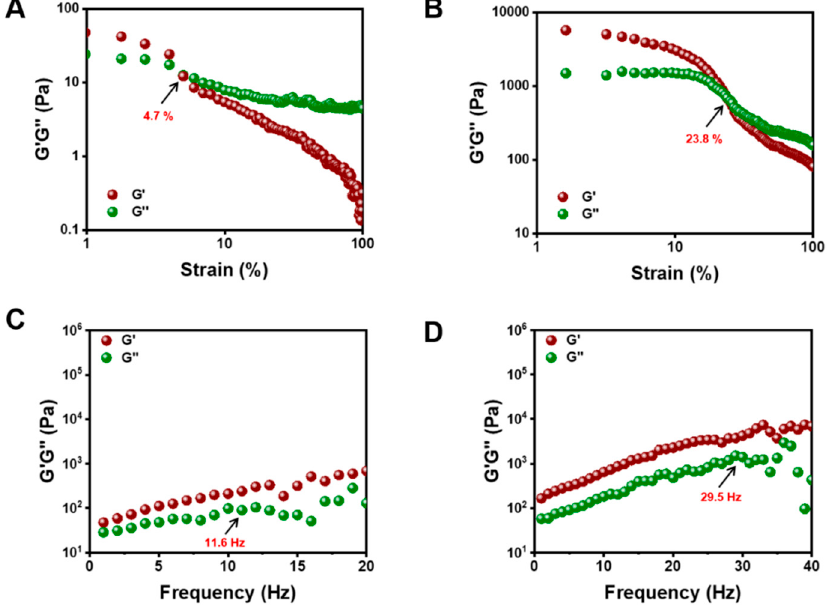
Figure 6. Amplitude sweep measurement of ( A , B ) PCLA and Lys-PCLA hydrogels. Frequency sweep measurement of ( C , D ) PCLA and Lys-PCLA hydrogels.